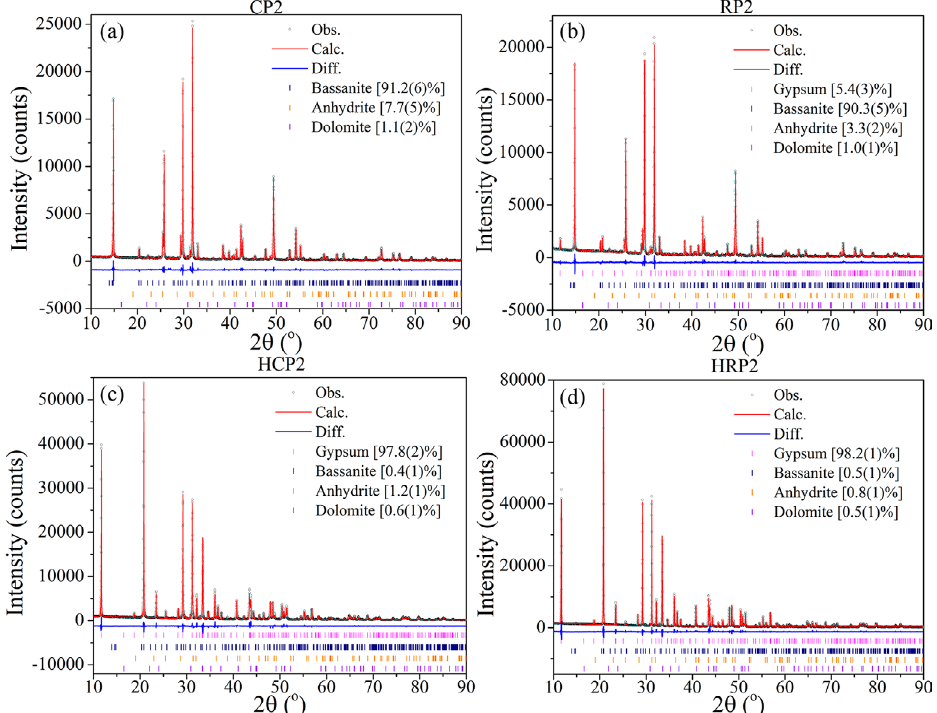
Figure 2. Rietveld plot and quantitative phase analysis of samples (a) CP2, (b) RP2, (c) HCP2, and (d) HRP2. The open circles represent the observed data, the red line represents the calculated values, and the blue line is the difference between the calculated and observed data. Vertical bars represent the peak positions of each